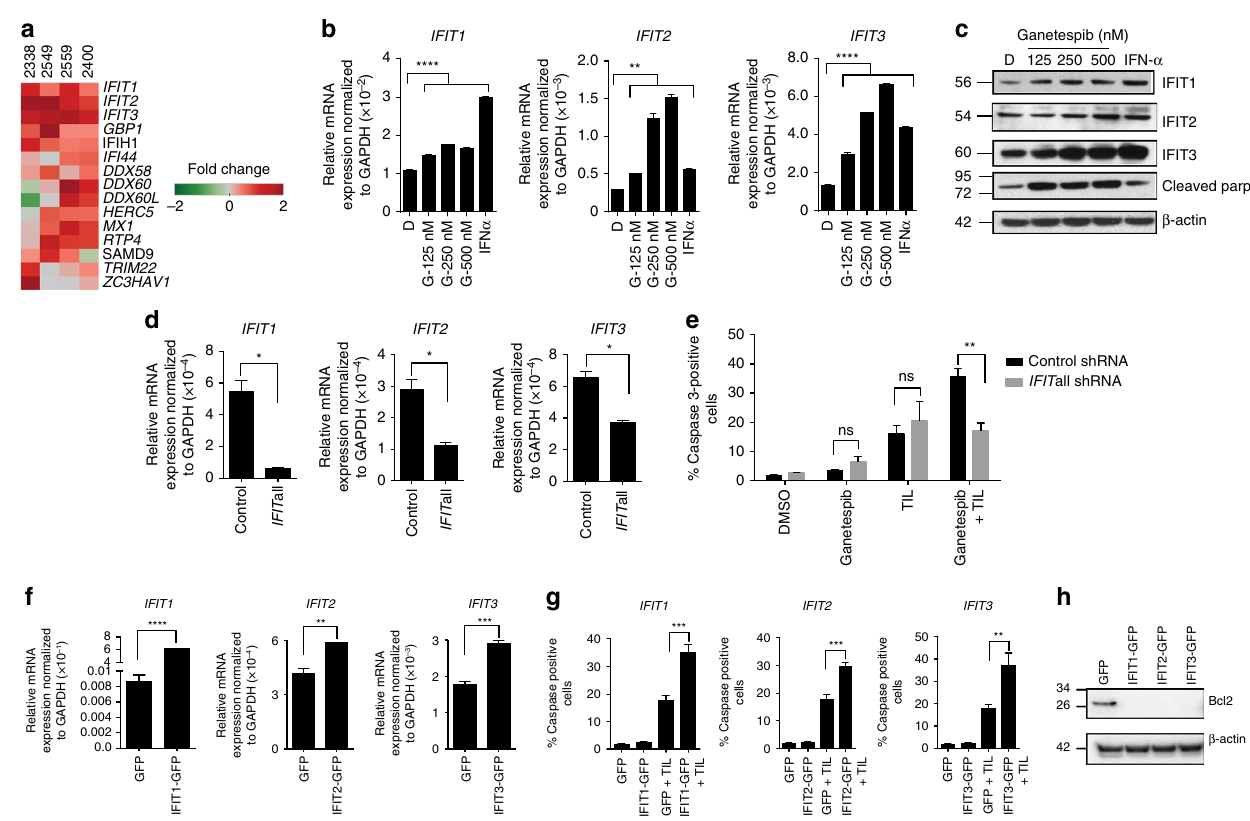
Fig. 2 HSP90 inhibitor effect on T-cell-mediated killing requires IFIT genes. a Gene expression analysis of cell lines treated with ganetespib. b , c Quantitative real-time PCR (qRT-PCR) and western blot analysis showing upregulation of IFIT1, IFIT2 and IFIT3 following ganetespib treatment in human melanoma cell line 2400. D = DMSO and G = ganetespib. Interferon alpha (IFN- α ) used as a positive control. An increase in cleaved PARP indicates ef fi cacy of the HSP90 inhibition by ganetespib. d qRT-PCR to verify silencing of IFIT1, IFIT2 and IFIT3 in 2400. Control = cell line transduced with scrambled shRNA and IFITall = cell line transduced simultaneously with IFIT1, IFIT2 and IFIT3 shRNAs. e 2400 Control and IFITall cell lines treated with ganetespib at 250nM, co-cultured with autologous T cells and assayed for cleaved caspase 3 by fl ow cytometry. f qRT-PCR verifying overexpression of IFIT1, IFIT2 and IFIT3 over GFP control in 2400. g 2400 GFP and IFIT overexpressing cell lines co-cultured with autologous T cells and assayed for cleaved caspase 3. h Western blots showing a decrease in BCL2 protein after overexpression of IFIT1, IFIT2 and IFIT3. The data represented as mean ± s.e.m. * P < 0.05; ** P < 0.01; *** P < 0.001; **** P < 0.0001. Data are a representation of at least two independent